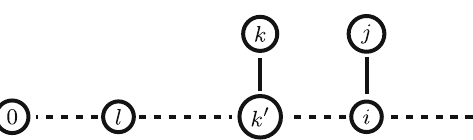
Figure 20: Minimum subgraph of C containing vertices { } l j k k n 0, , , , ′, , when < ≤ l n 0